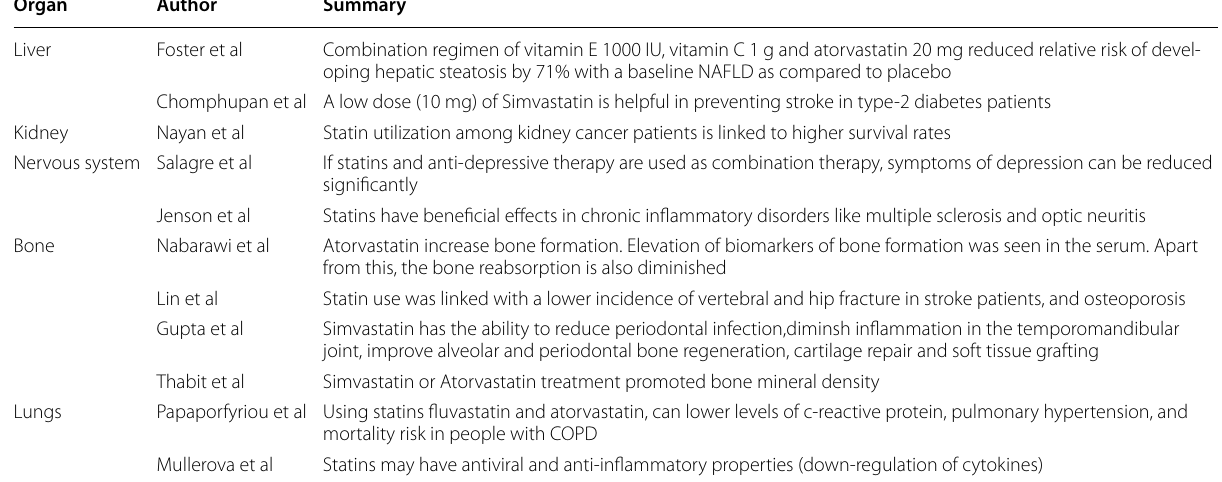
Table 1 Effect of statin on different organs of the body